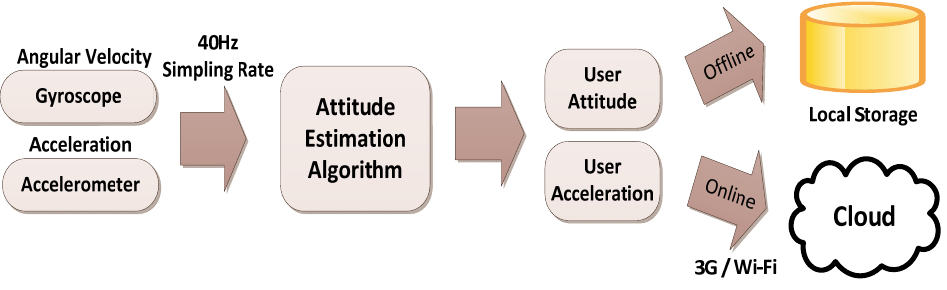
Figure 2. The flowchart of client-side operations.